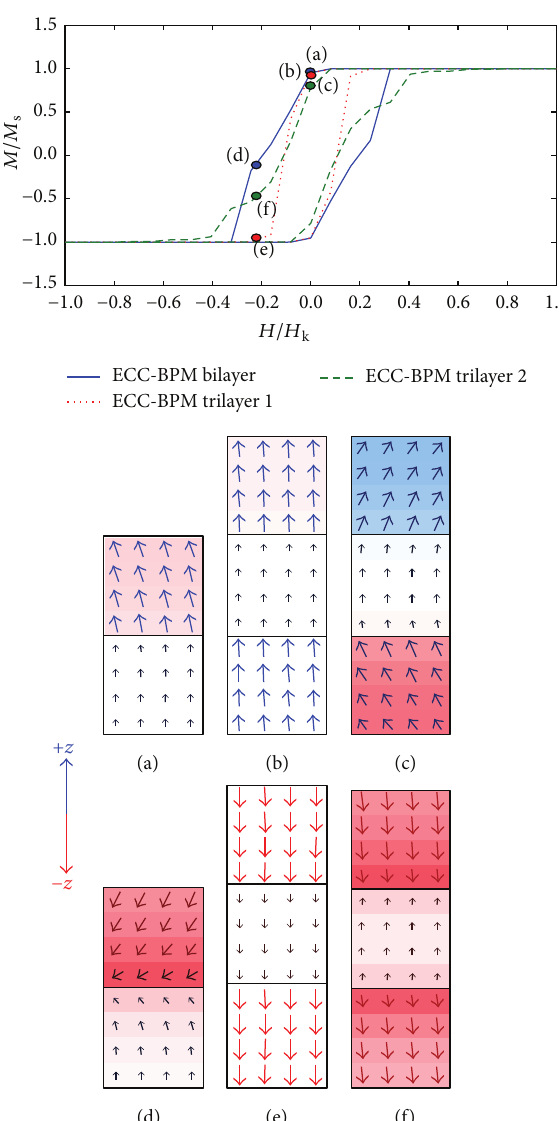
Figure4:HysteresisloopsofECC-BPMbilayerwith 𝐴 10 pJ/m (solid line), trilayer 1 with 𝐴 line), and trilayer 2 with 𝐴 line). Magnetization reversal process of single dot in bilayer: (a) and (d), trilayer 1: (b) and (e), and trilayer 2: (c) and (f). Magnetization reversal of (a)–(c) without 𝐻